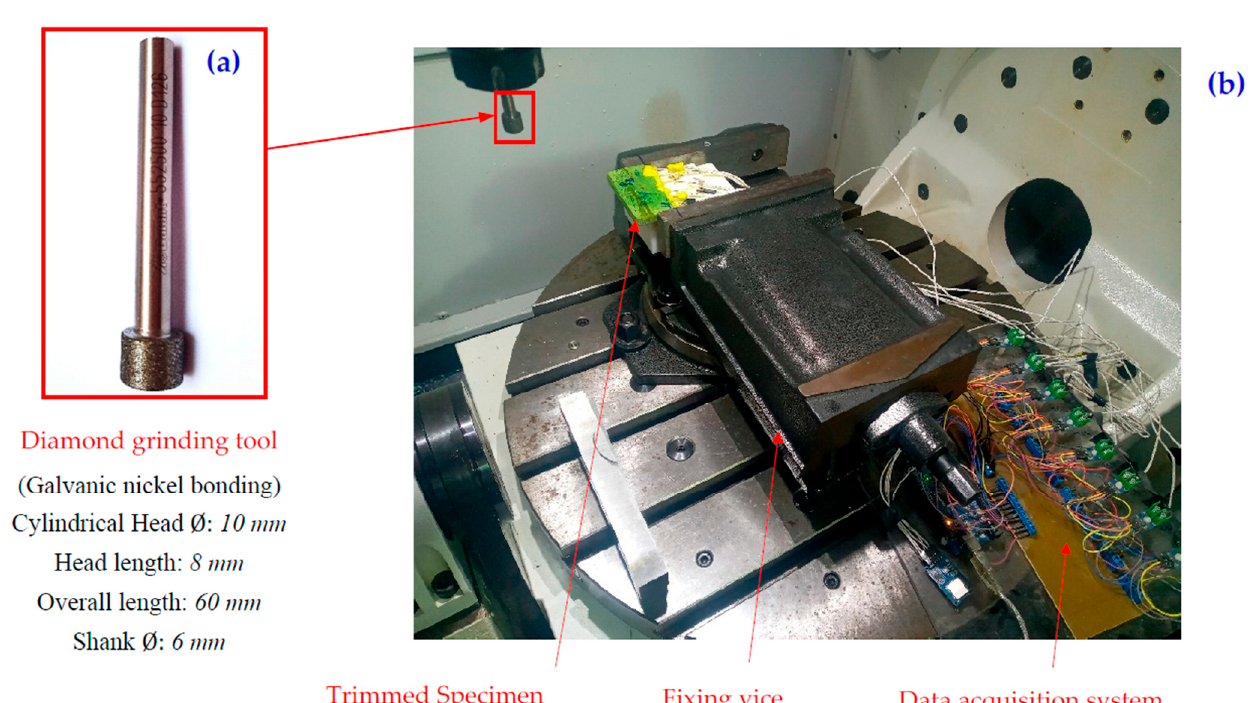
Figure 2. ( a ) Cutting tool configuration, ( b ) Edge milling test set-up. Table 4. Technical characteristics of data acquisition instruments [37].